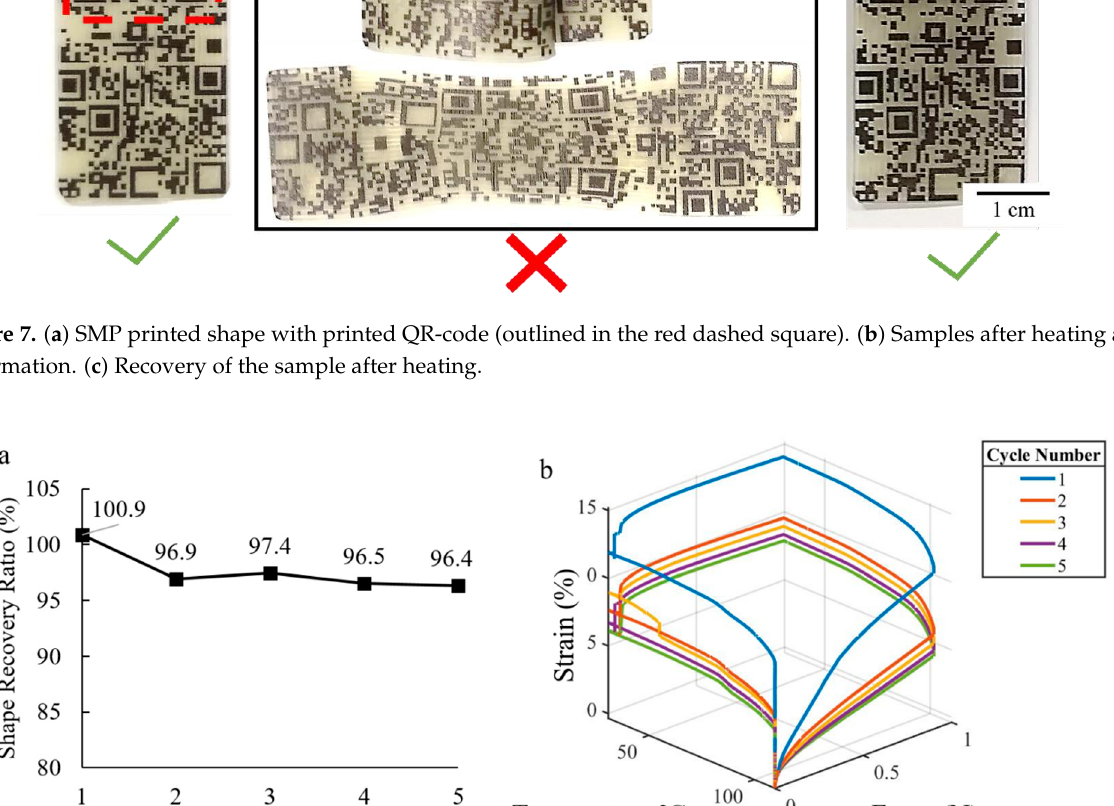
Figure 8. Thermal cycle of Shape memory polymer vs. shape recovery ratio ( a ), strain % and load (N) as function of tem- perature ( b ).